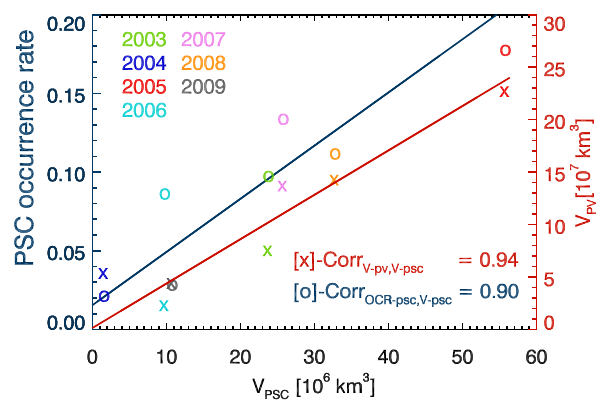
Fig. 7. Scatter plot of February mean PSC occurrence rate over the Arctic and the PSC volume taken from WMO (2011) (open circles and blue line), and scatter plot of averaged polar vortex volume from this study integrated over the 450–600K isentropic levels over the Arctic in February and PSC volume taken from WMO (2011) (crosses and red line).